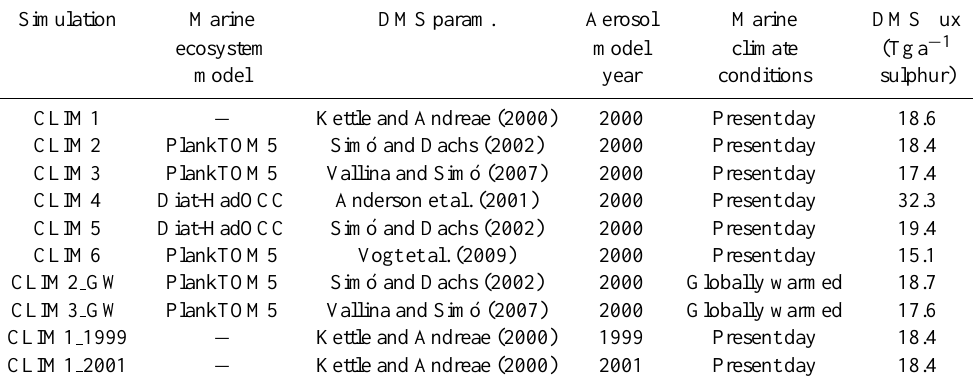
Table 1. Summarising the differences between the experiments. Aerosol model year refers to the meteorological year that GLOMAP-mode is being forced by. The final column shows calculated annual fluxes of DMS. See text for further details. Simulation Marine DMS param. Aerosol Marine DMS flux ecosystem model climate (Tga − 1 model year conditions sulphur) CLIM1 − Kettle and Andreae (2000) 2000 CLIM2